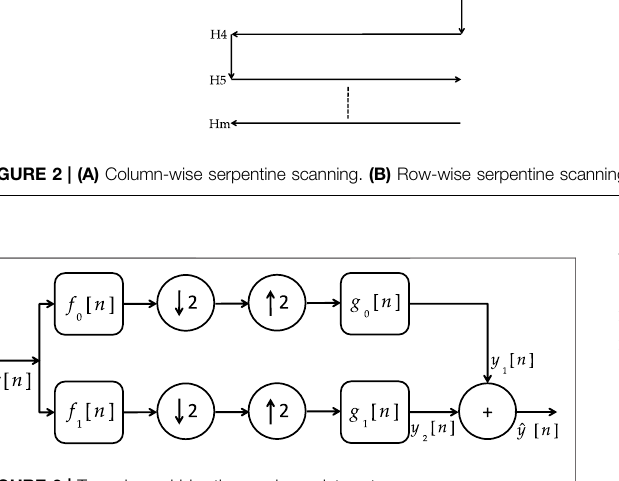
FIGURE 3 | Two-channel bi-orthogonal wavelet